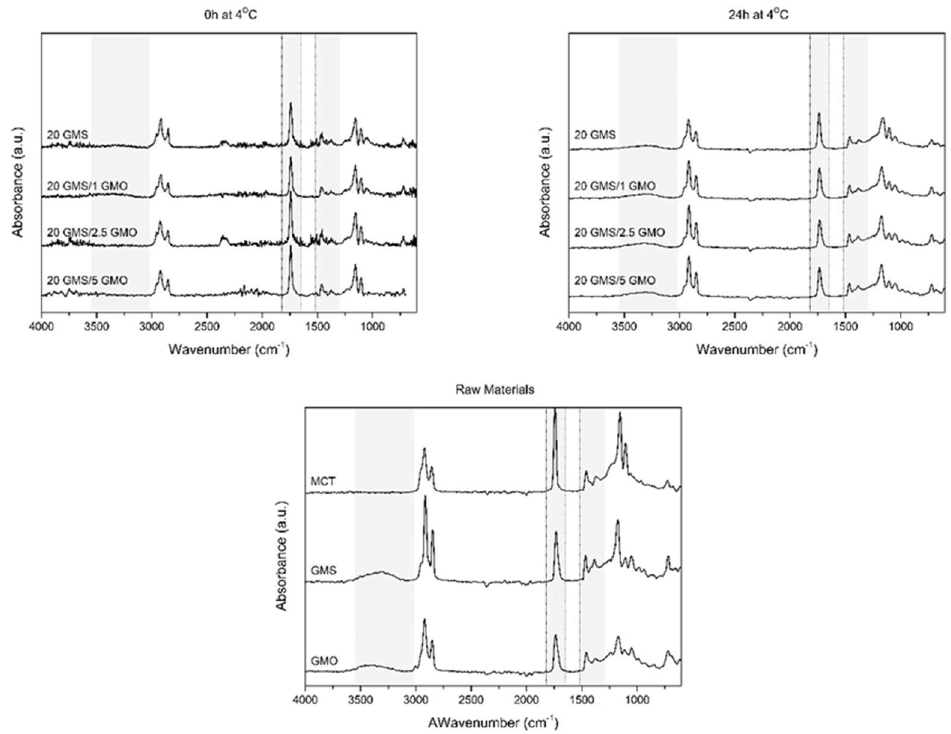
Figure 5. FTIR spectra of oleogels after cooling to room temperature (t = 0 h at 4 ◦ C) and after 24 h of storage at 4 ◦ C (t = 0 h at 4 ◦ C) alongside the spectra of raw